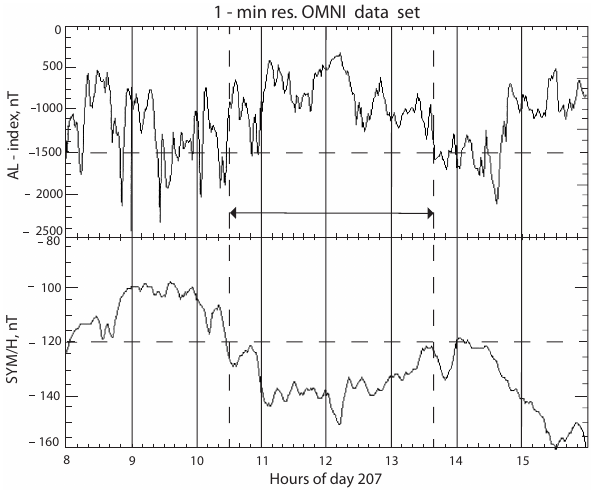
Figure 6. Geomagnetic indices AL (nT) and SYM-H (nT) for the interval 08:00–16:00UT on 25 July 2004. The attenuated substorm activity (reduced AL deflection peaks) during the interval 10:30– 13:40UT is marked by vertical guidelines and horizontal double- arrowed line.